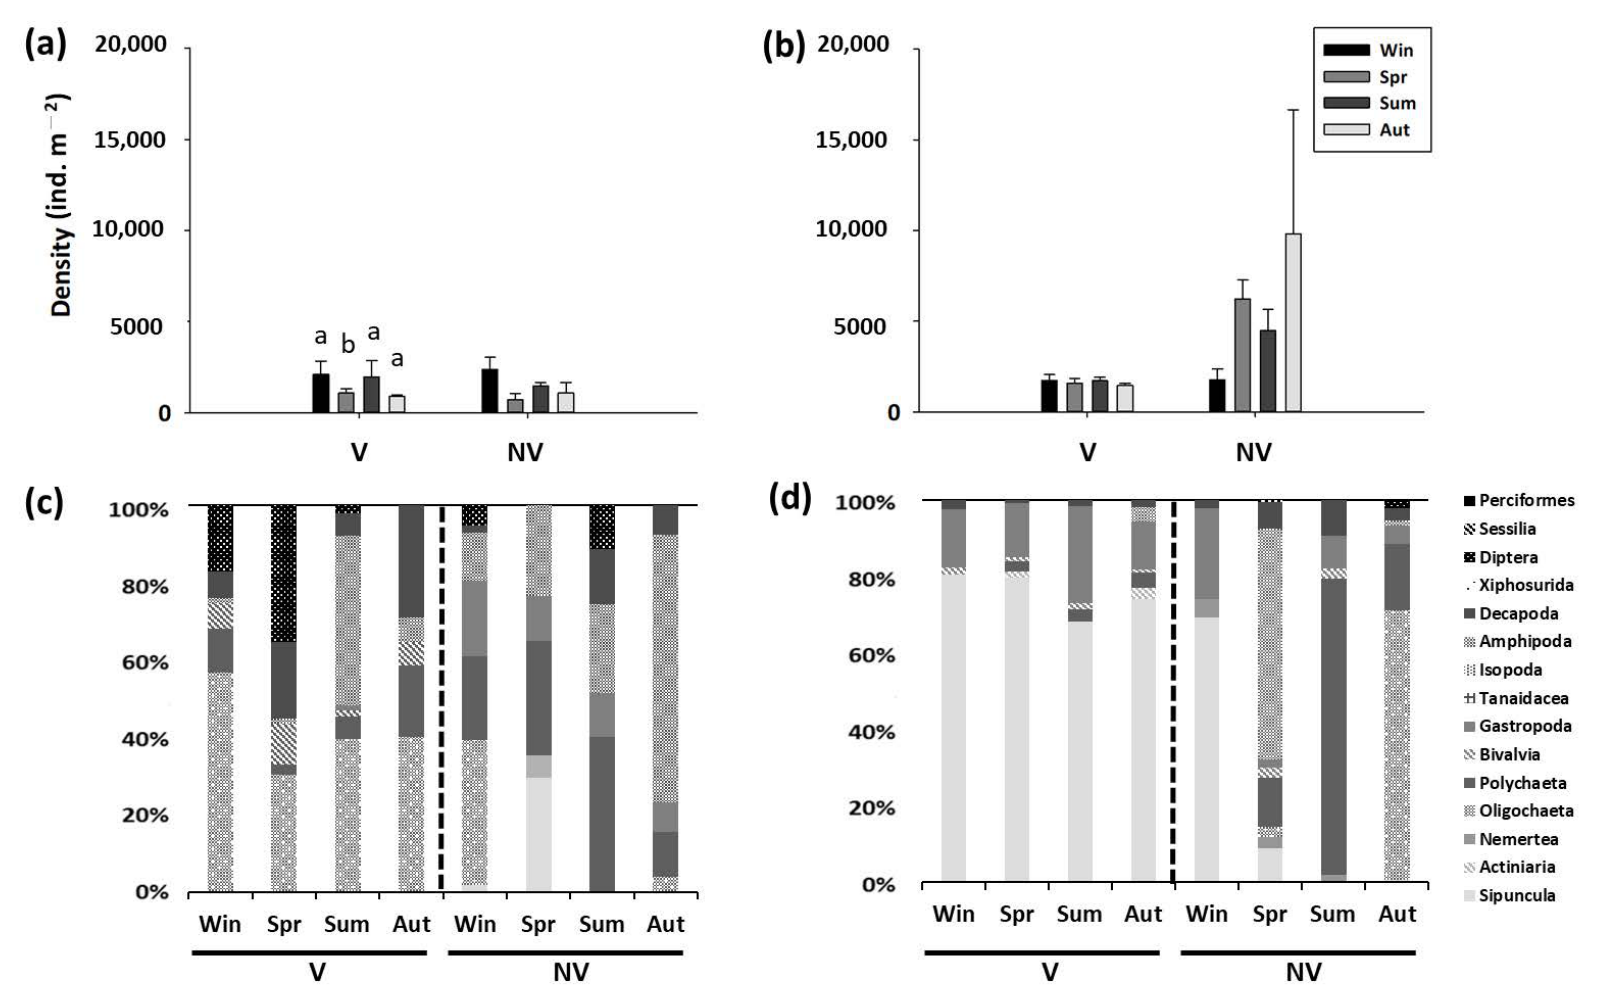
Figure 1. Seasonal variations in the density (mean ± SE) and macrobenthic community composition in the Kandelia obovata (S., L.) mangroves in ( a , c ) XF and ( b , d ) ZN. v, mangroves; nv, nonvegetated mudflats; win, winter; spr, spring; sum, summer; aut, autumn. Within each site, different letters above columns denote significant ( p < 0.05) differences among seasons with the Tukey’s post-hoc